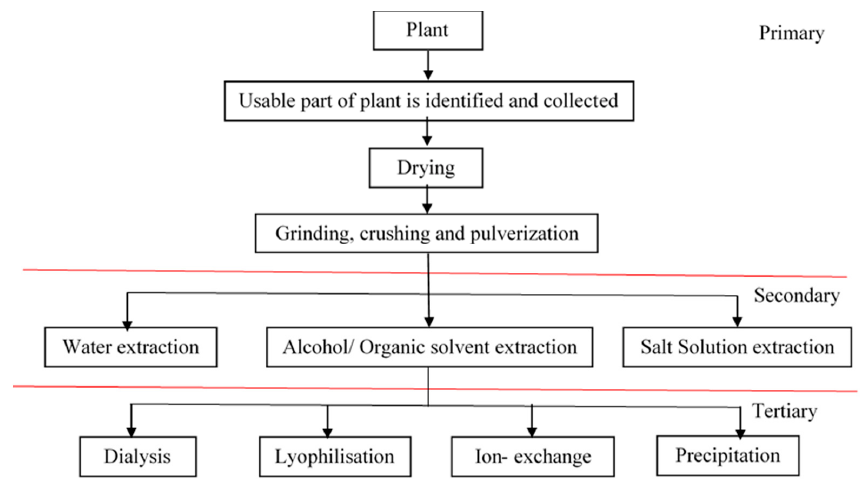
Figure 2. General processing steps in plant based coagulant extraction.